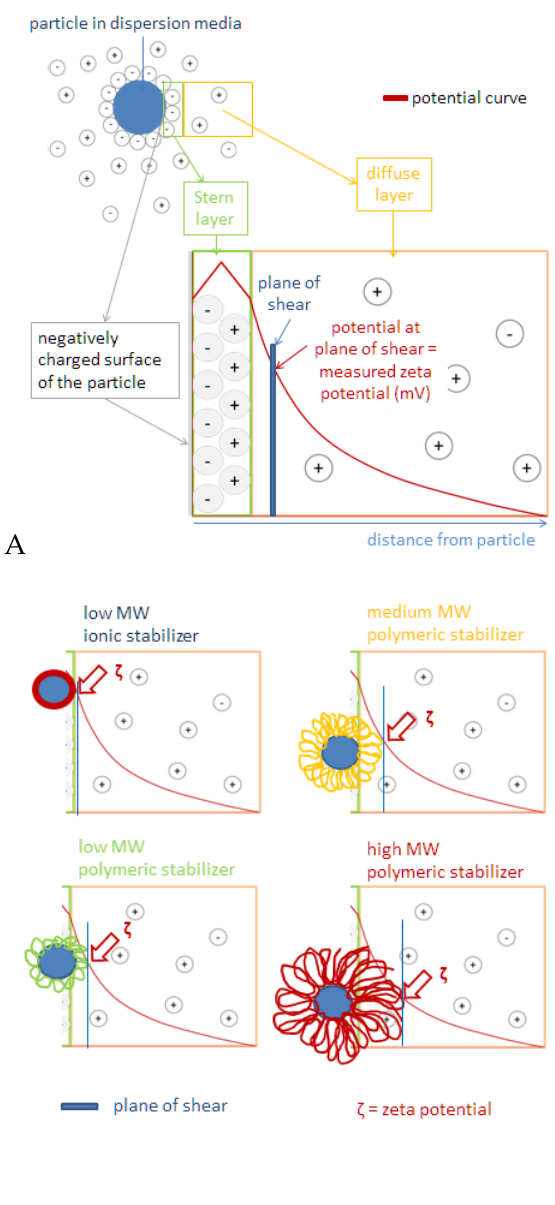
Figure 1. The model of zeta potential theory. ( A ) The course of the potential in the different layers; ( B ) when polymer are used for stabilization, the shear plane is shifted due to the adsorption layer resulting in decreased zeta potential.